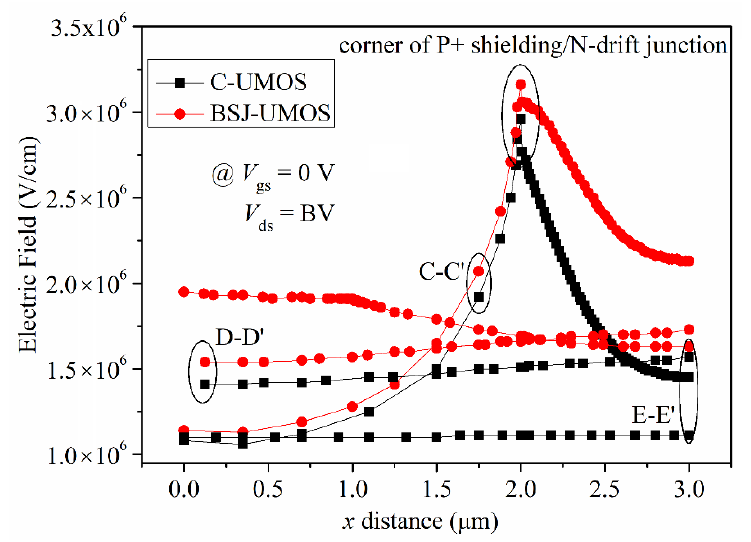
Figure 8. Electric field distributions of BSJ-UMOS and C- UMOS along CC’ ( y = 3.4  m), DD’ ( y = 6.0  m) and EE’ ( y = 11  m) lines, as shown in Figure